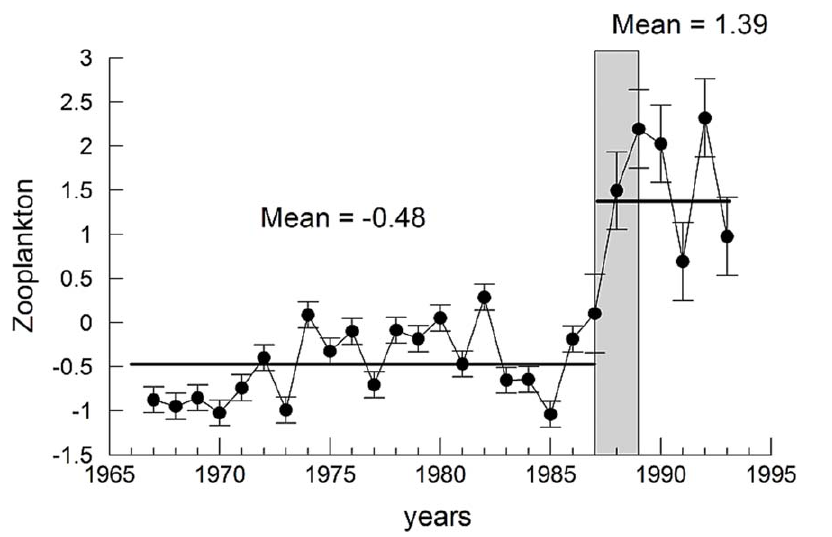
Figure 3. Changes in zooplankton abundance (standard units), measured off Villefranche, Ligurian Sea, western Mediterranean, 1966–1993. The horizontal lines correspond to the means of the subperiods 1966–1987 and 1988–1993. The vertical grey bar shows indicatively the period of change (late 1980s).